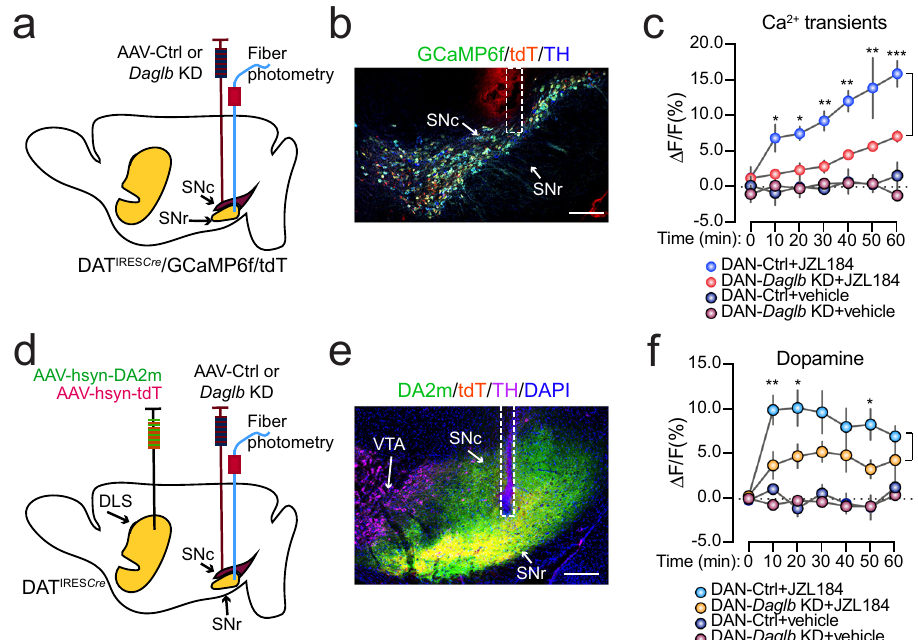
Fig. 7 JZL184 treatment promotes DAN activity and dopamine release. a Schematic illustrates fi ber photometry recording of GCaMP6f and tdT signals in the SNc of DAN-control and DAN- Daglb KD Dat IRESCre /GCaMP6f/tdT trigenic mice. b Representative images of GCaMP6f (green), tDT (red), and TH (blue) staining. Scale bar: 200 μ m. Six independent experiments were performed. c Alterations of calcium transients in the SNc of DAN-control and DAN- Daglb KD Dat IRESCre /GCaMP6f/tdT trigenic mice ( n = 3M per genotype) treated with vehicle or JZL184 (20 mg/kg). Data were presented as mean ± SEM. Multiple unpaired t test, two-tailed, * p < 0.05, ** p < 0.01, *** p < 0.001. d Schematic illustrates fi ber photometry recording of DA2m and tdT signals in the SN of DAN-control and DAN- Daglb KD mice. e Representative images of DA2m (green), tDT (red) and TH (magenta) staining. Scale bar: 200 μ m. Nine independent experiments were performed. f Changes of dopamine release in the SN of DAN-control ( n = 5 M) and DAN- Daglb KD ( n = 4 M) mice treated with vehicle, JZL184 (20 mg/kg). Data were presented as mean ± SEM. Multiple unpaired t test, two-tailed, * p < 0.05, ** p < 0.01.